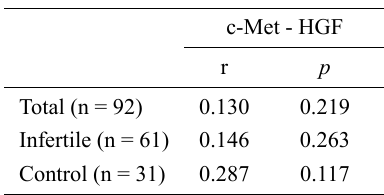
Table 3. Correlation between c-Met expression and HGF Table 5. Correlation between sperm motility percentage and levels. the HGF and c-Met expression levels.